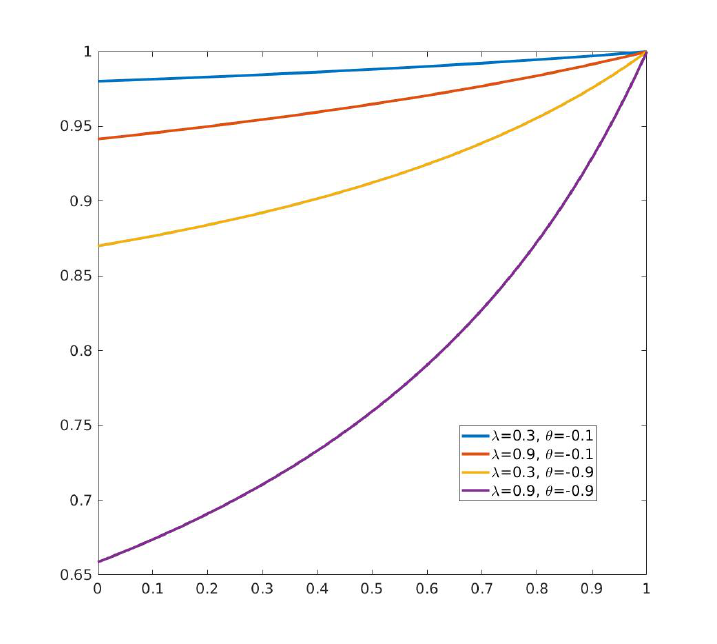
( x ) = exp( λ ((2 − x ) θ − 1)) for λ ∈ { 0.3, 0.9 } and θ ∈ { −0.9, −0.1 } λ , θ